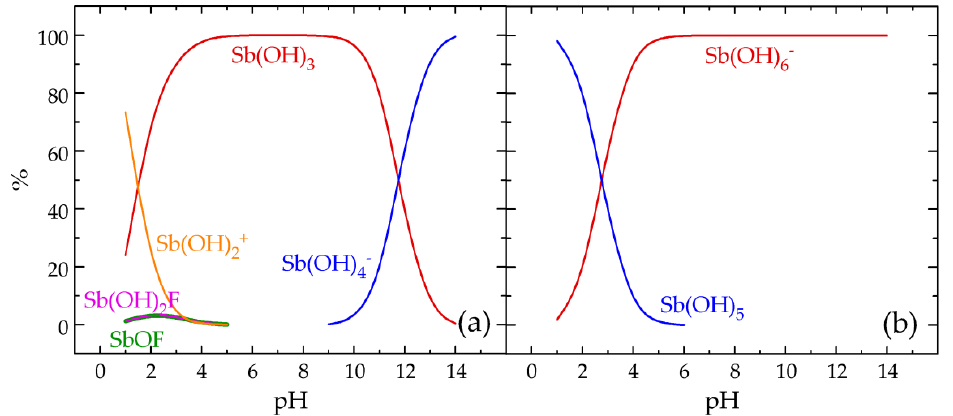
Figure 1. Percentage of ( a ) Sb(V) and ( b ) Sb(III) species at concentrations 100 µ g/L in tap water matrix and 20 ° C. Diagrams derived by Visual MINTEQ 3.0 (http://vminteq.lwr.kth.se).